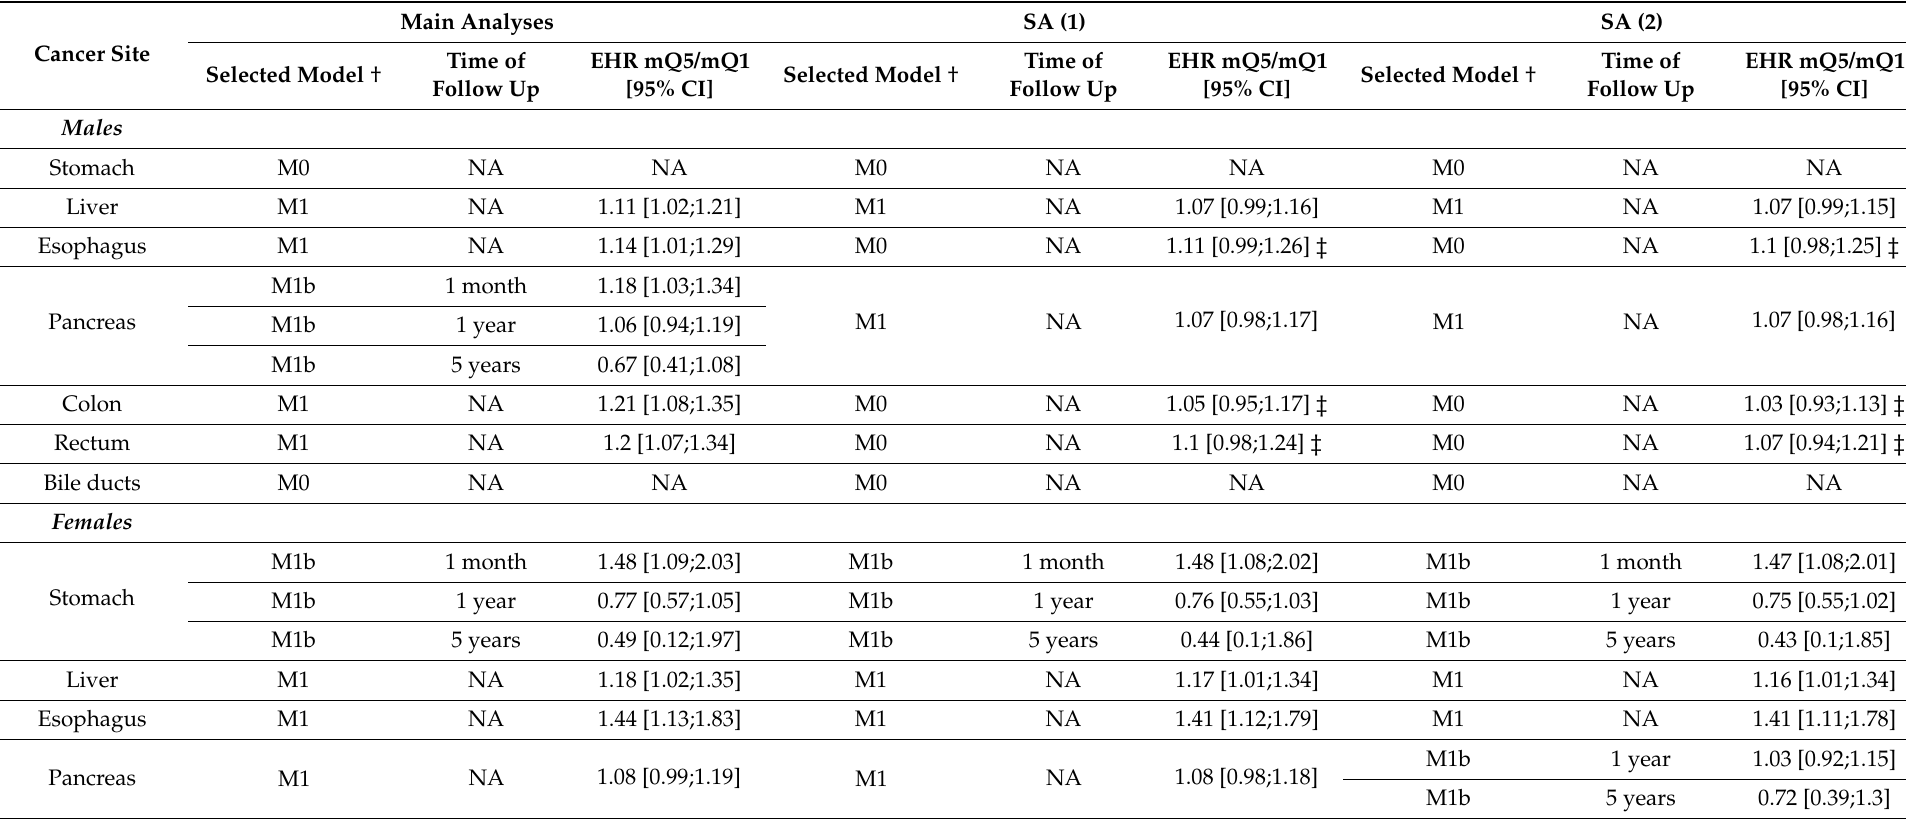
Table 4. Selected model and excess hazard mortality ratio (EHR) between mQ5 (most deprived) and mQ1 (least deprived) according to analysis (main or sensitivity) for each cancer site and